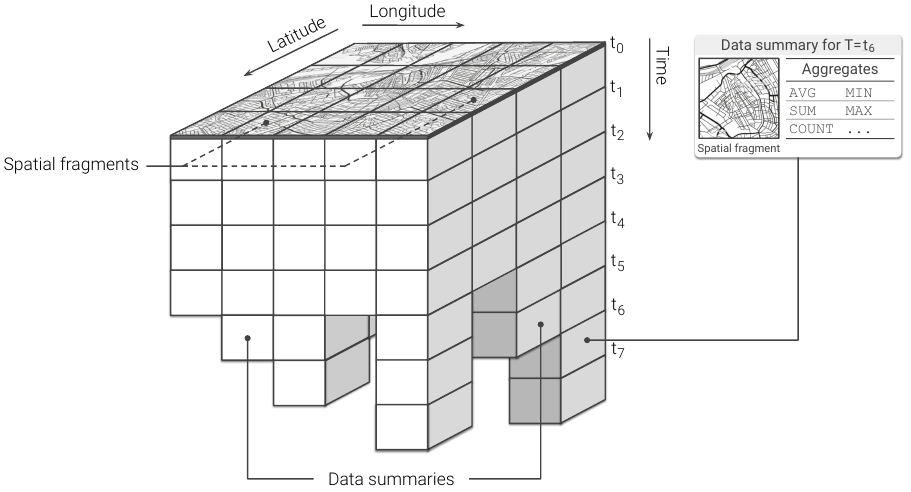
Figure 4. Spatiotemporal fragmentation for continuous computing of data